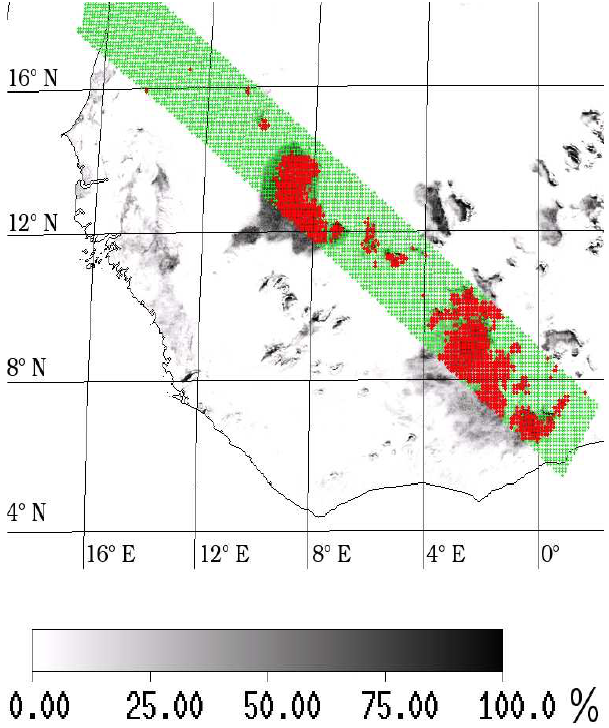
Fig. 6. EPSAT-SG rainfall probability estimate (gray scale) collo- cated with TRMM/PR.